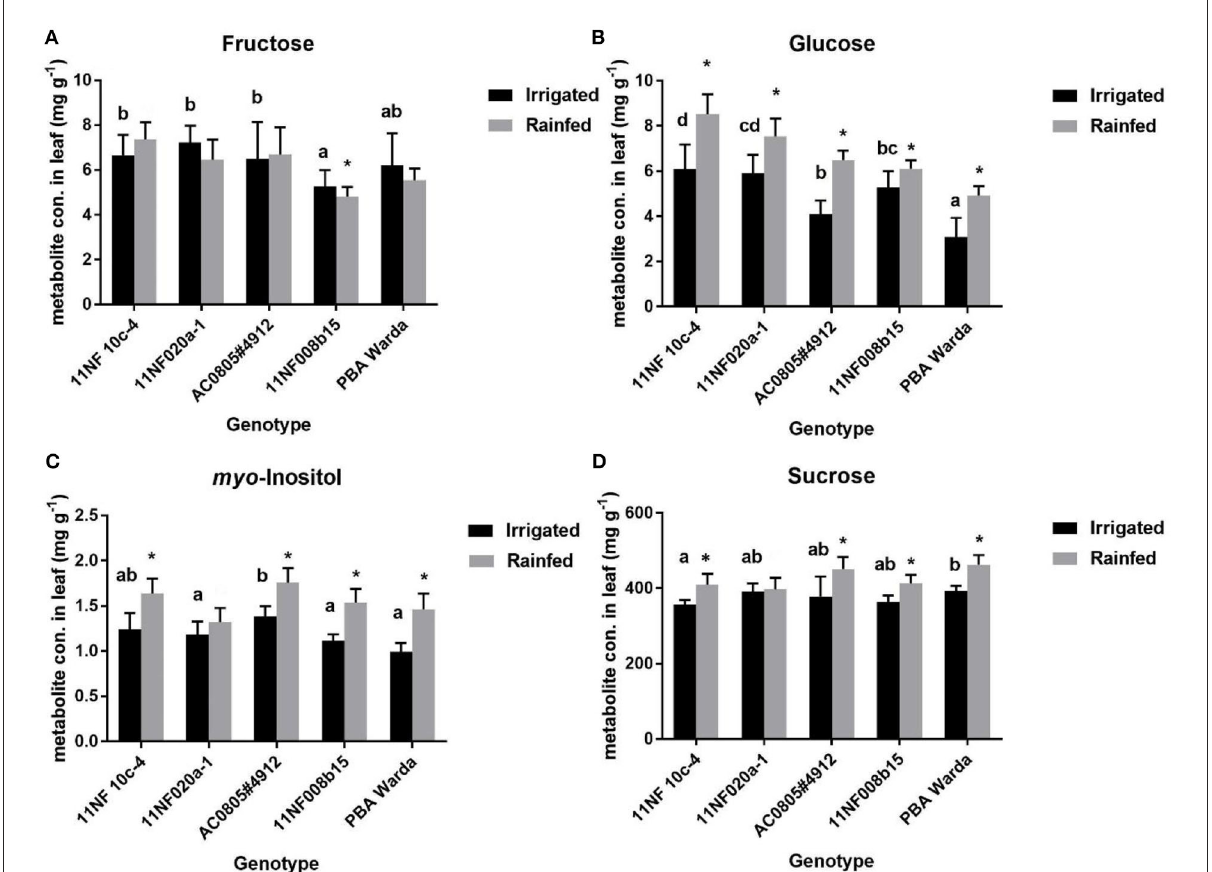
FIGURE4 Average metabolite concentrations (mg g − 1 leaf material) in contrasting faba bean genotypes under rainfed and irrigated conditions. Error bars were calculated from four replicates and represent standard error of the mean. Different letters denote a significant difference ( p < 0.05) among genotypes calculated through DMRT. Asterisks (*) represent significance between irrigated and rainfed treatments. (A) Fructose, (B) Glucose, (C) myo-Inositol and (D)